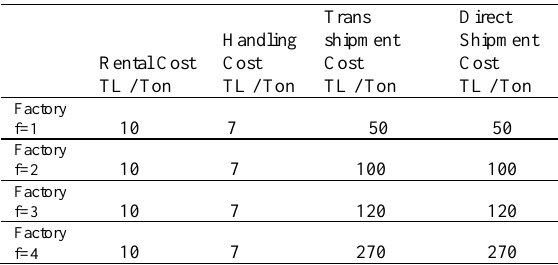
Table 4. Operational cost items